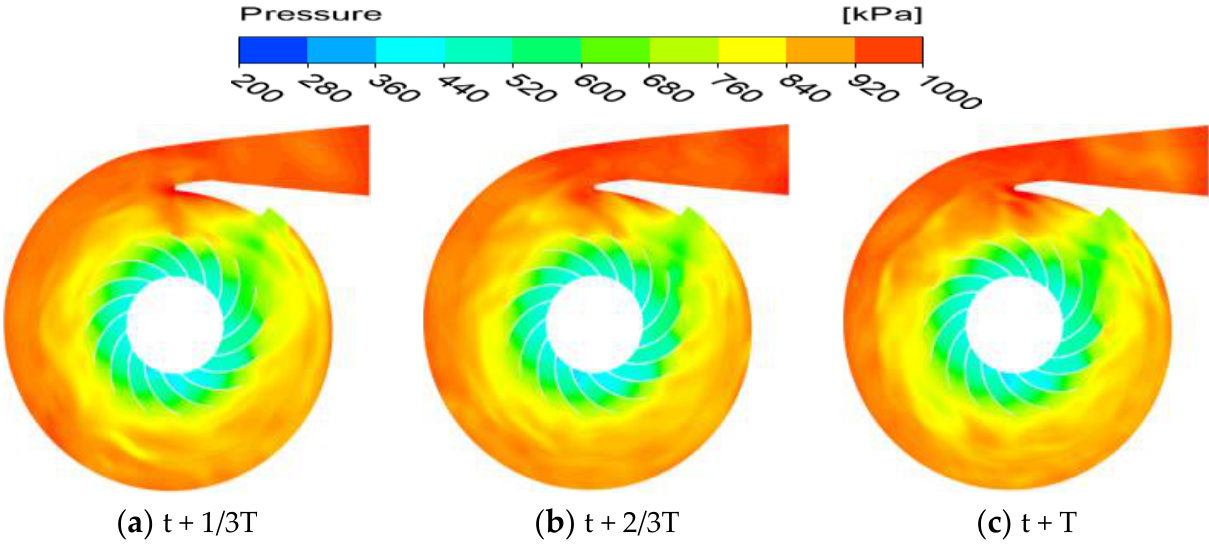
flow instability within the impeller is exacerbated, which is a precursor to the appearance Figure 10. Distribution and development of pressures at the z = − 12 mm cross-section and near-stall Figure 10. Distribution and development of pressures at the z = −12 mm cross -section and near-stall of secondary flow. Overtime, flow deterioration is observed at 120° of the vaneless mass-flow rate (0.8 Qn =22.62 kg/s) from 0.0569 to 0.06259 mass-flow rate (0.8 Qn =22.62 kg/s) from 0.0569 to 0.06259 s.